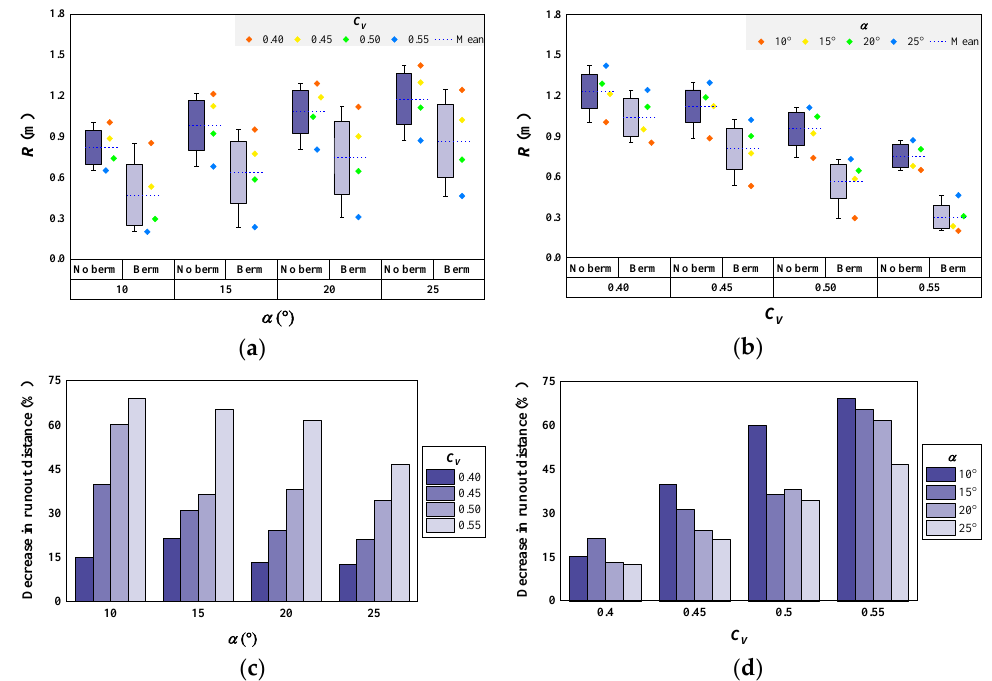
Figure 6. ( a ) Runout distance according to α (when C V = 0.40 – 0.55); ( b ) runout distance according to C V (when α = 10° – 25°); ( c ) percentage decrease in runout distance due to berm according to α (when C V = 0.40 – 0.55); ( d ) percentage decrease in runout distance due to berm according to C V (when α = 10° – 25°).